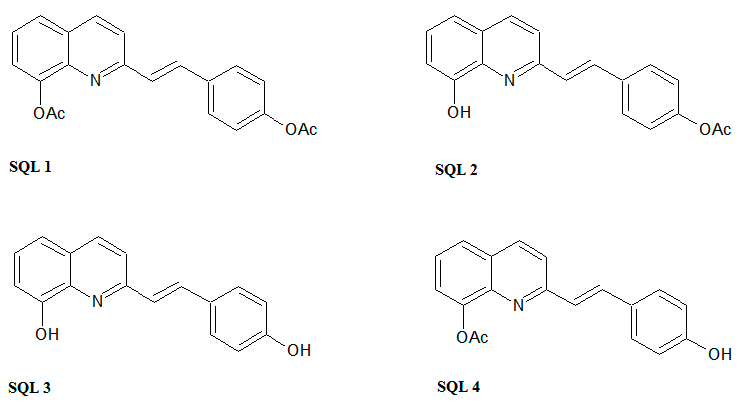
Figure 2. The styrylquinolines (SQLs) that were synthesized in this study.